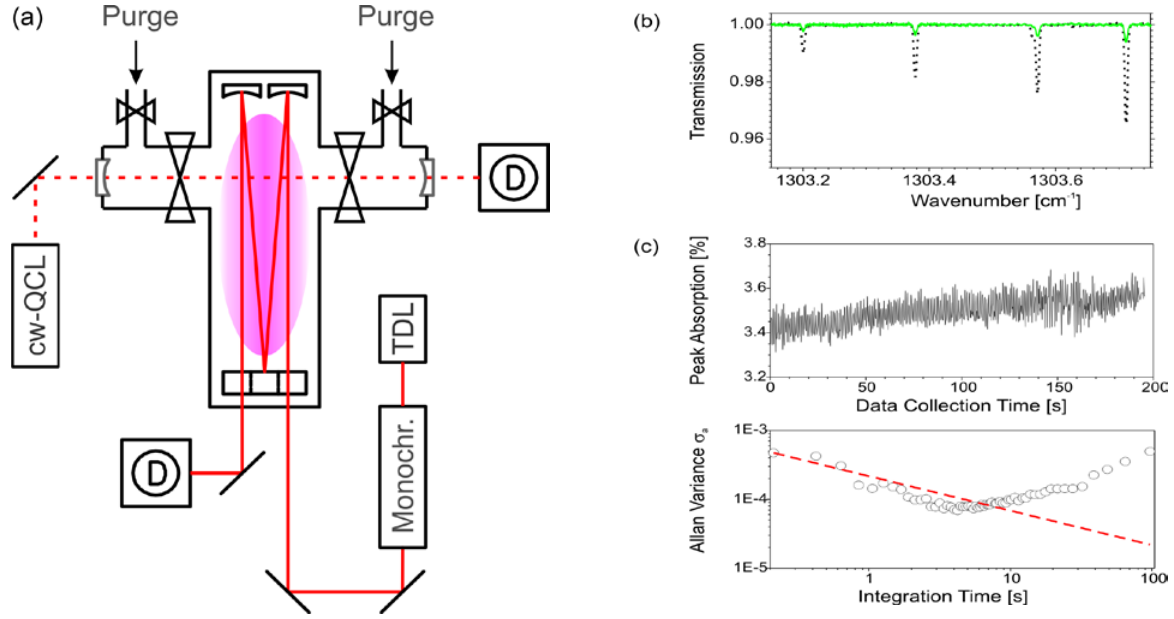
Figure 13. (a) Schematic diagram of the experimental setup used for IR-LAS with a planar MW discharge reactor. A 7.67 µm cw-QCL was guided through purged viewing apertures perpendicular to a lead salt TDL spectrometer aligned to achieve 24 passes within an in-situ White cell having a 1.5 m mirror separation ( L = 36 m). The single pass QCL TDL absorption path (reactor clearance) was L = 0.2 m. (b) CH transmission spectra QCL 4 measured with the cw-QCL in a CH -Ar plasma [25 sccm + (225 sccm + 20 sccm purge 4 gas), 1.5 mbar, 0.7 kW input power, dotted line] and an O -Ar plasma 2 [20 sccm + (15 sccm + 25 sccm purge gas), 1.5 mbar, 0.7 kW input power, solid line]. (c) Upper: CH peak absorption at 1,303.71 cm -1 as a function of time in the CH -Ar 4 4 discharge shown in (b). Lower: Allan plot retrieved from the data stream plotted in the upper panel (symbols). The trend in white noise is indicated (dashed